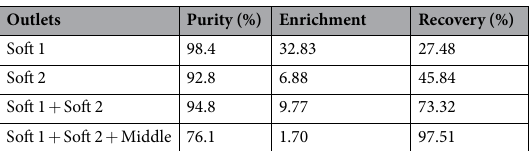
Table 4. Purity and enrichment obtained for cord